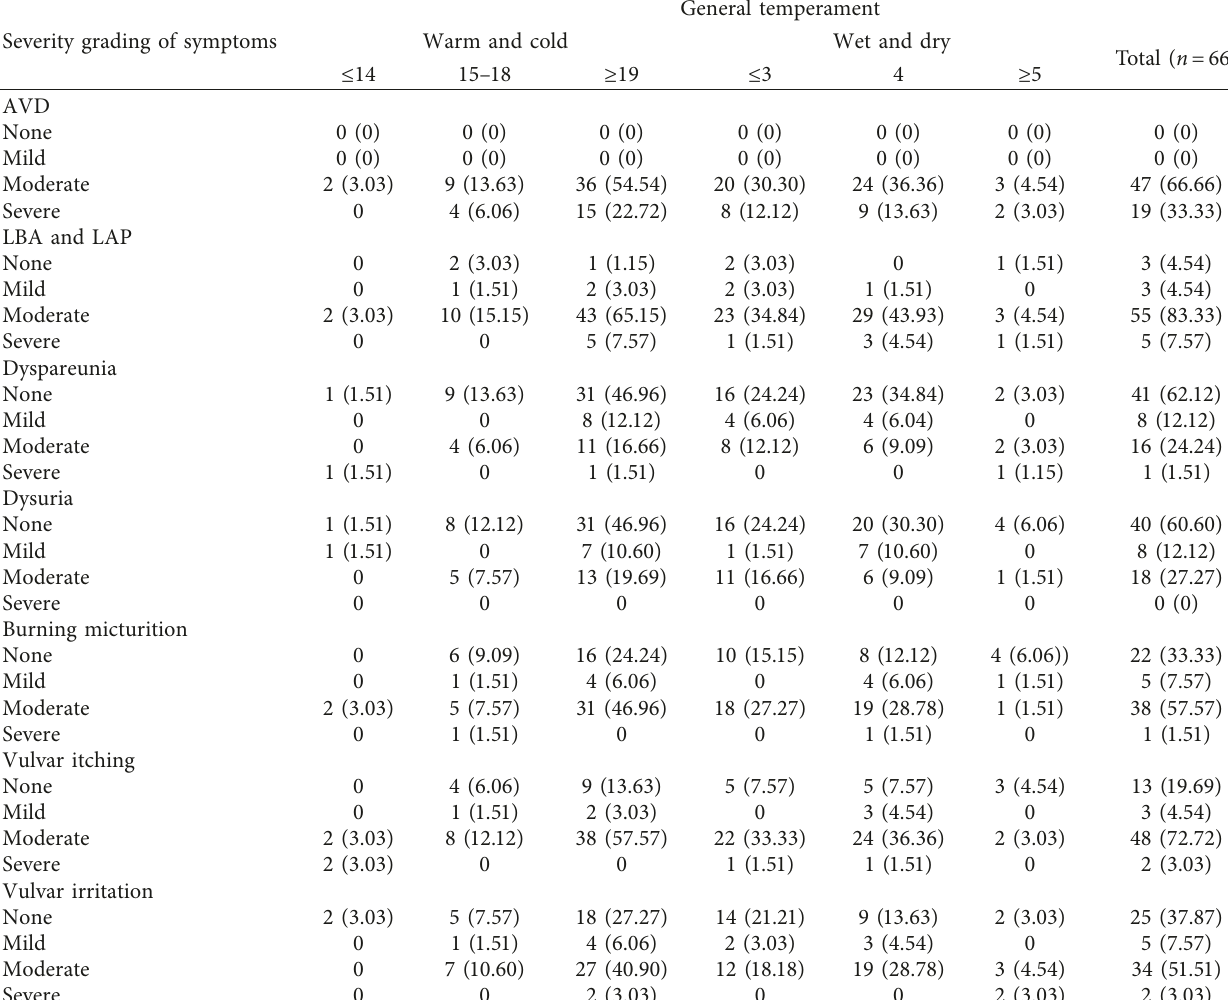
Table 4: Severity of symptoms and general